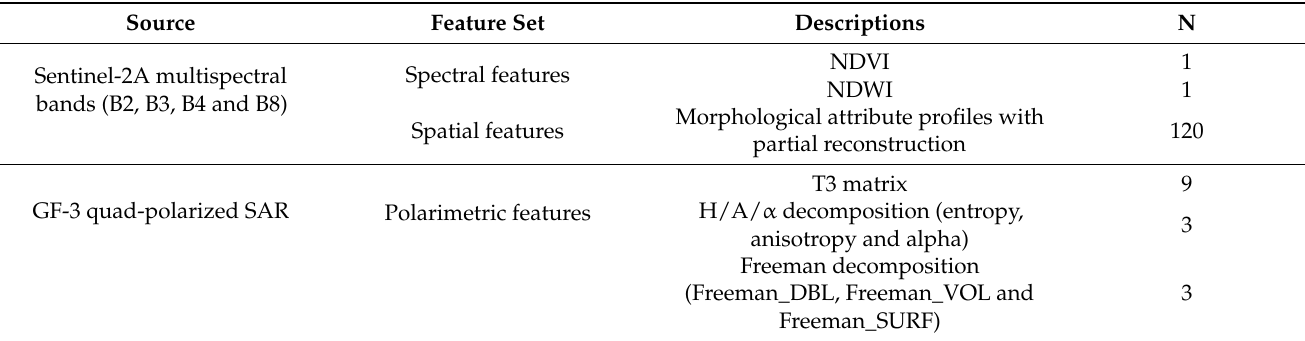
Table 2. Feature sets and the number of features ( n ) per